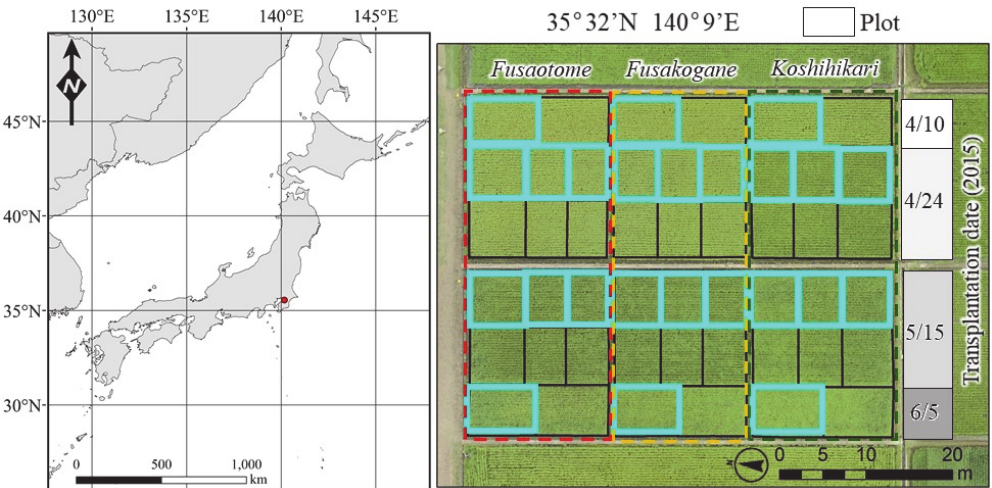
Figure 1. Map of the test sites: Chiba Prefectural Agriculture and Forestry Research Center. The grain protein content was observed for each sample (blue plot) from 2015 to 2017. Table 1. The list of cultivation conditions of the test sites (2015 to 2017). Year Test